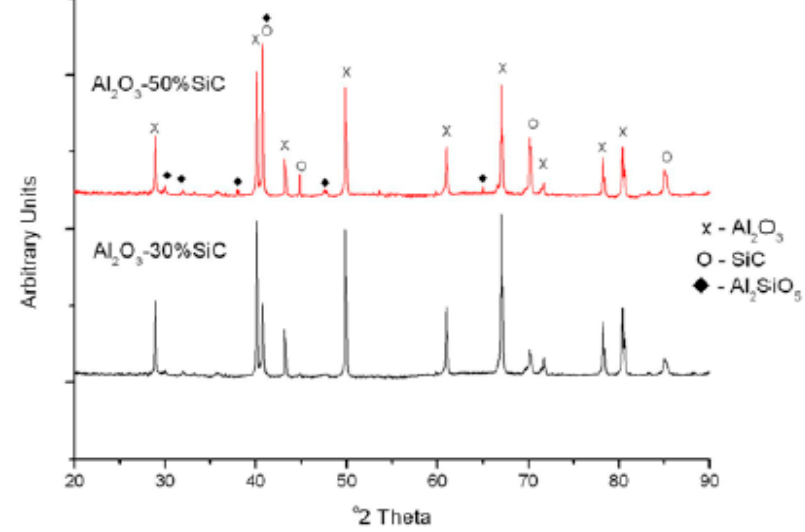
Figure 6. X-ray diffraction (XRD) of Al 2 O 3 –SiC nanocomposite. Reproduced with permission